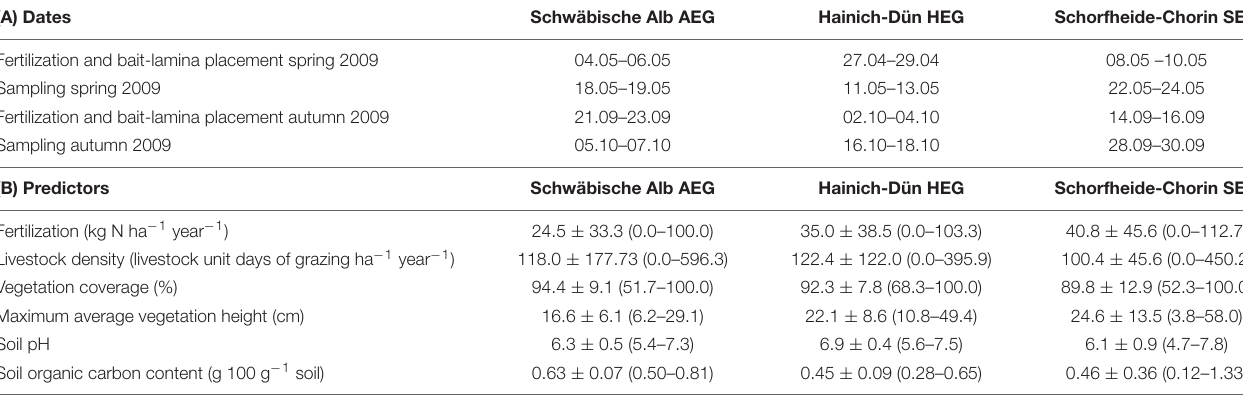
TABLE 1 | (A) Dates of experimental fertilization, placement and collection of bait-lamina strips and soil fauna sampling in spring and autumn 2009, (B) 3-year averages (2006–2008) of N fertilization and livestock density, maximum average vegetation height, vegetation surface coverage, soil pH and soil organic carbon content (means ± SD and ranges) for the 12 grasslands sites in each of the three study regions.